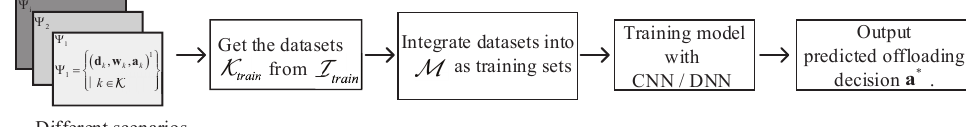
Figure 3. The pipeline of DSLO training.